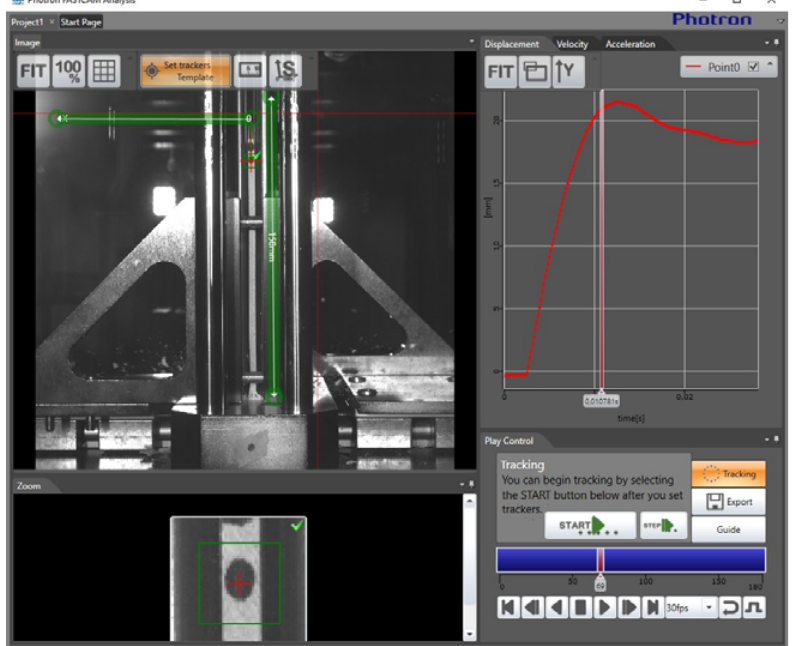
Figure 5: Tracking of the displacement of the specimen during the crush test from the high-speed video using the Photron PFA software.